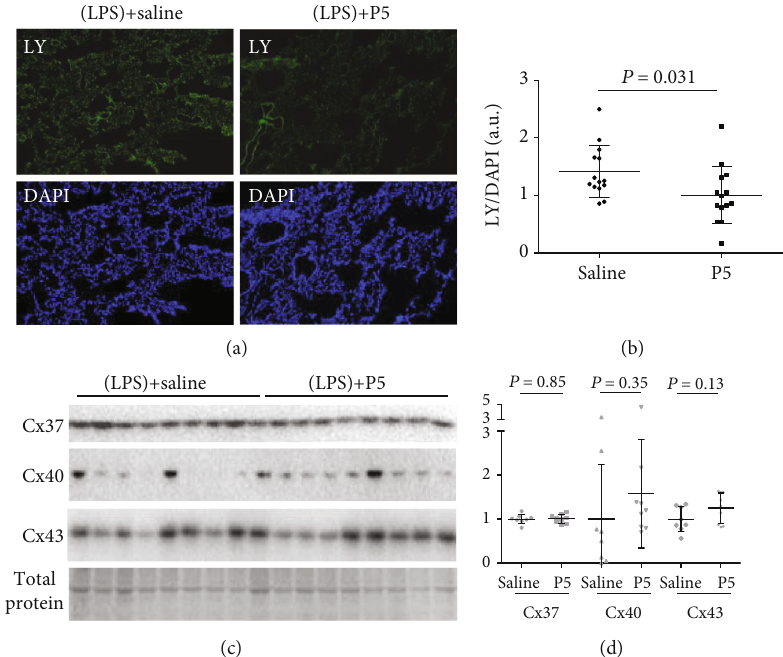
Figure 2: The e ff ects of P5 on HC permeability (a, b) and Cx expression (c, d) of alveolar cells in vivo. (a, b) At 20hr after LPS challenge, saline or P5 was administered (ip) twice at 2 and 16 hr post-ALI induction. After 10min, mouse lungs were perfused with PBS, fi xed with PF, and then cut into sections that were subsequently stained with DAPI. LY-containing cells appeared in green, showing LY uptake through HCs. Nuclei of all alveolar cells were stained with DAPI and appeared in blue. The ratio of LY/DAPI fl uorescence signals was used to determine HC activity. a.u.: arbitrary unit. (c, d) Saline or P5 was administered (ip) twice at 2 and 16 hr post-ALI induction. After BALF extraction, lungs were harvested and homogenated to determine the expression of Cx37, Cx40, and Cx43 by Western blotting.